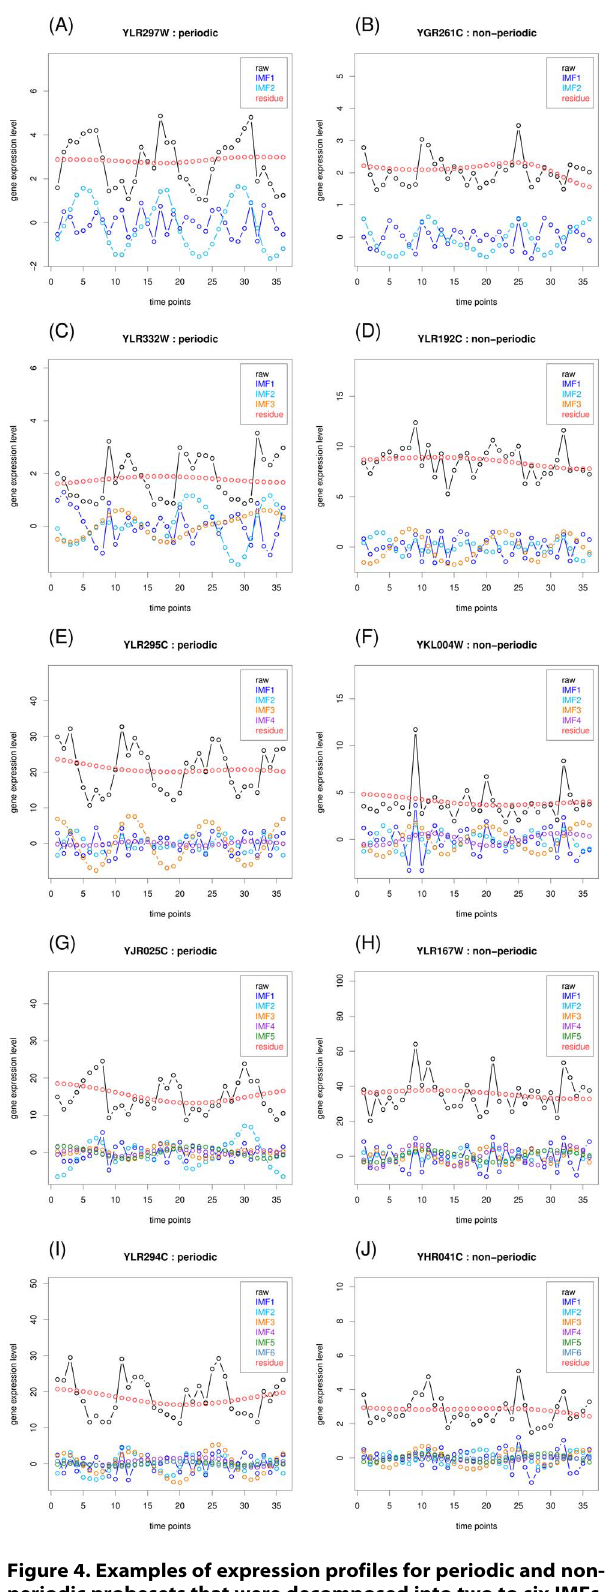
Figure 4. Examples of expression profiles for periodic and non- periodic probesets that were decomposed into two to six IMFs. The left column presents the periodic probesets. The right column presents the non-periodic